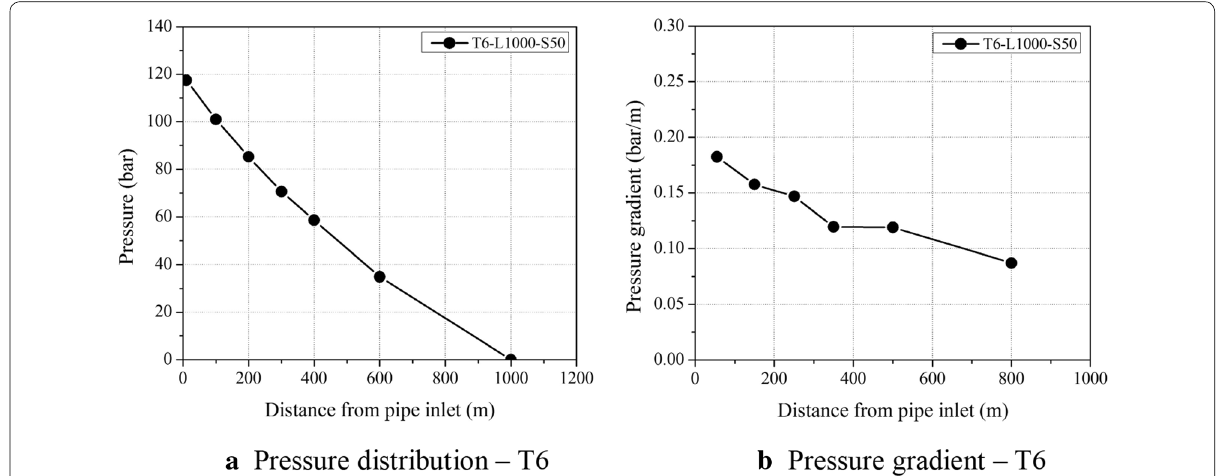
Fig. 9 Results of pressure and pressure gradient over the pipe length—decrease slope.